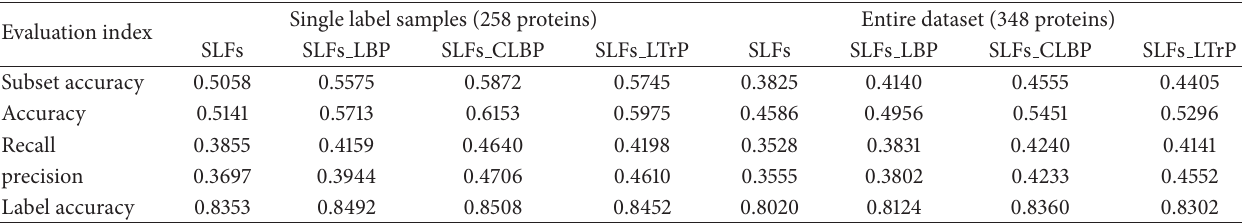
Table 4: Five evaluation index comparisons based on single-label and entire dataset by using BR model fed into different combinations of local and db6 global features.